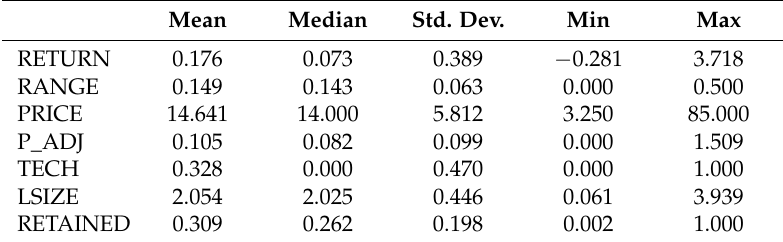
Table 1. Descriptive statistics for the dependent and independent variables. RETURN represents market adjusted first trading day return. Independent variables are the width of price range (RANGE); offering price (PRICE); initial public offerings (IPO) price adjustment (P_ADJ); dummy variable representing whether the company operates in the technology space (TECH); the size of the